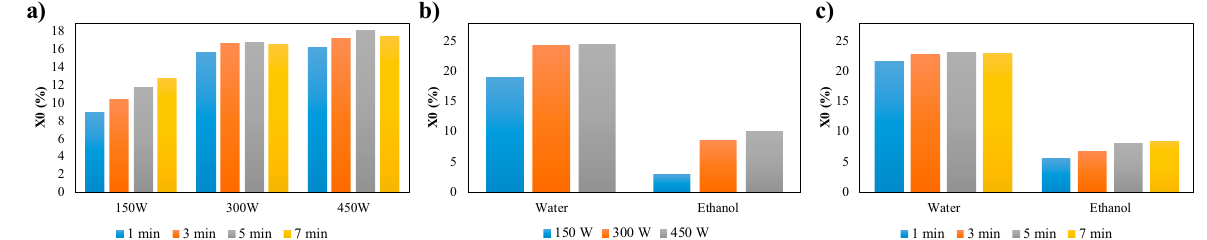
Figure 2. Effect of the process parameters on global yield: ( a ) time and power, ( b ) power and solvent, and ( c ) extraction time and solvent. Results expressed on a dry basis. Standard deviation by ANOVA = 0.6.